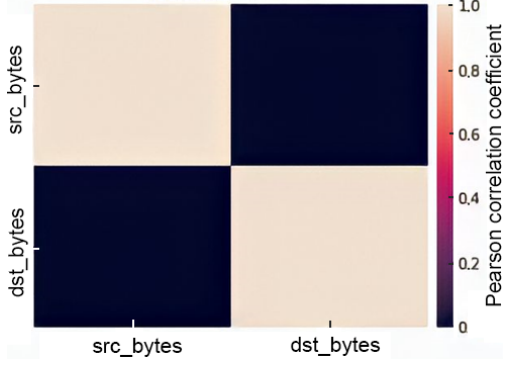
Fig. 6 Pearson correlation.